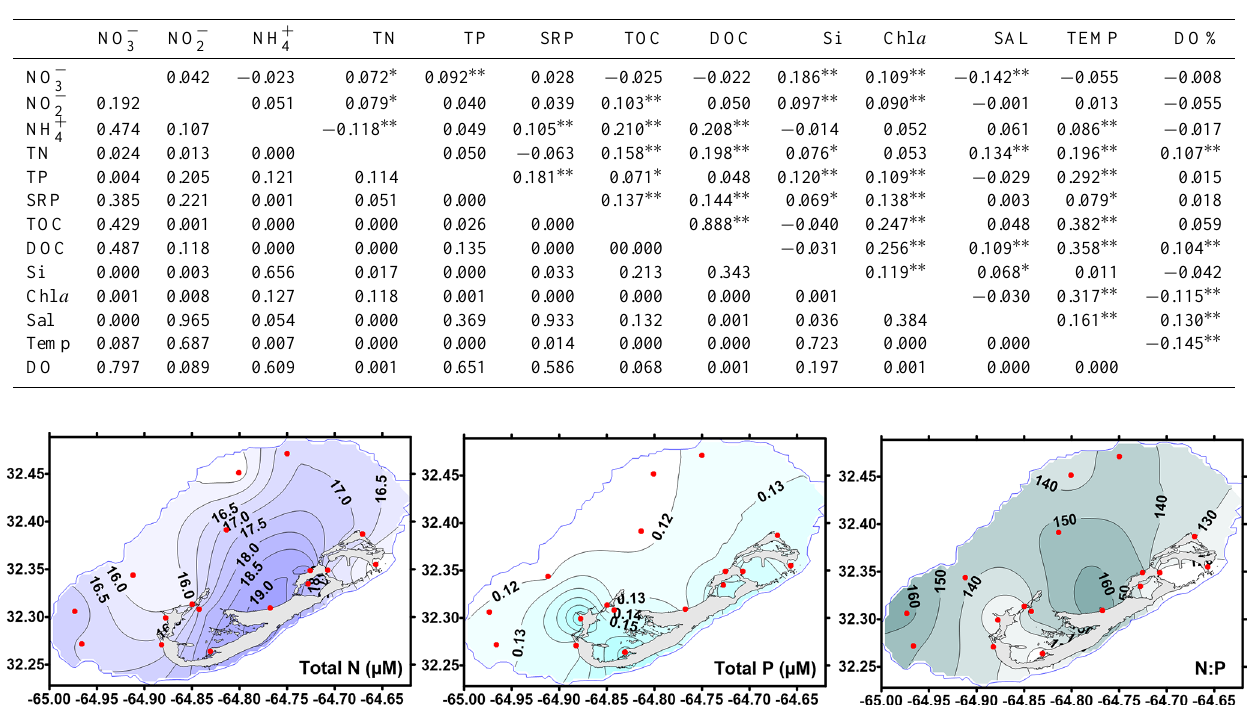
Table 1. Pearson’s correlation of water quality data, correlation coefficient ( ρ ) above the diagonal, and two-tailed test of significance of the correlation ( p ) below the diagonal. The number of observations for each quantity are in Supplement Table S1; in general n ≈ 1000. ∗ Indicates p ≤ 0 . 05; ∗∗ indicates p ≤ 0 . 01.